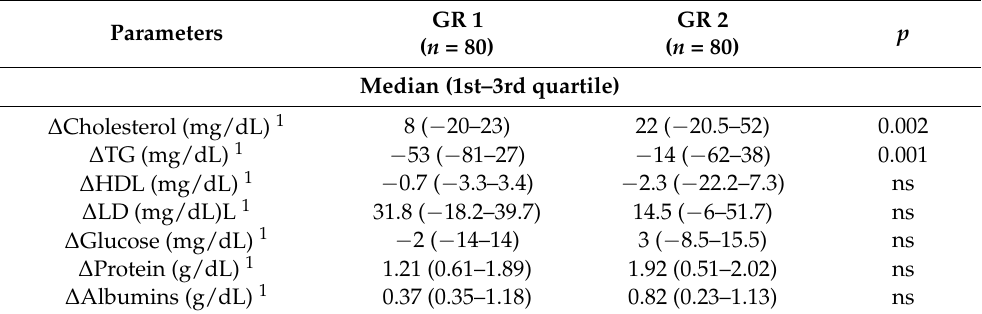
Table 4. Comparison of metabolic parameters between the study groups at the end of the trial-delta versus